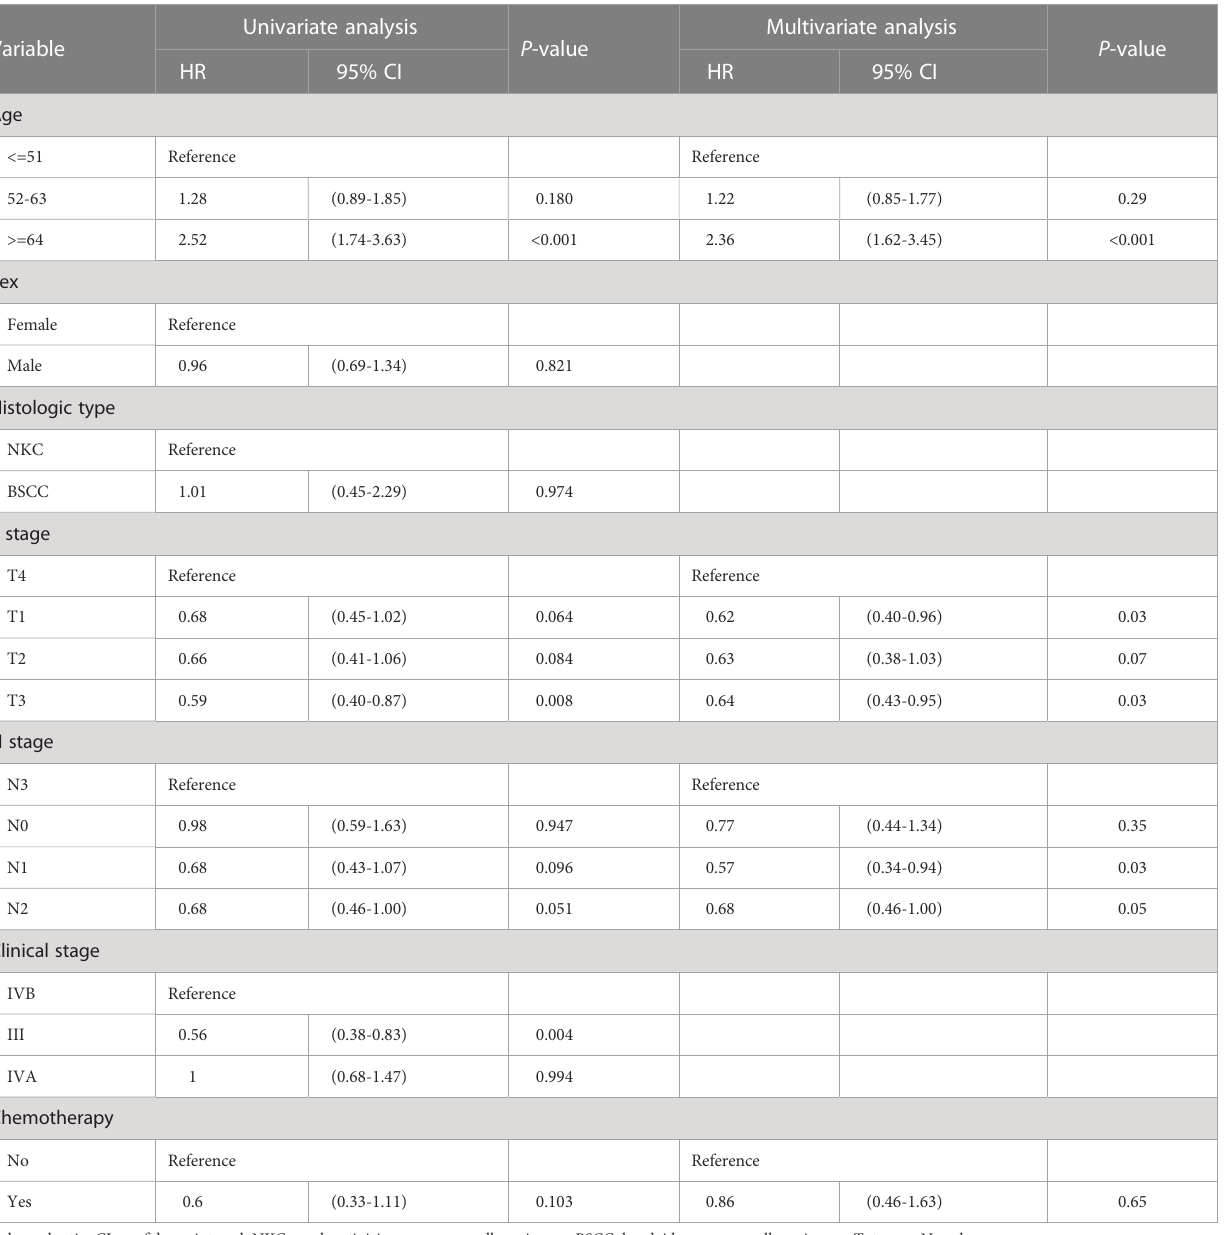
TABLE 2 Univariate and multivariate Cox analyses of LA-NPC